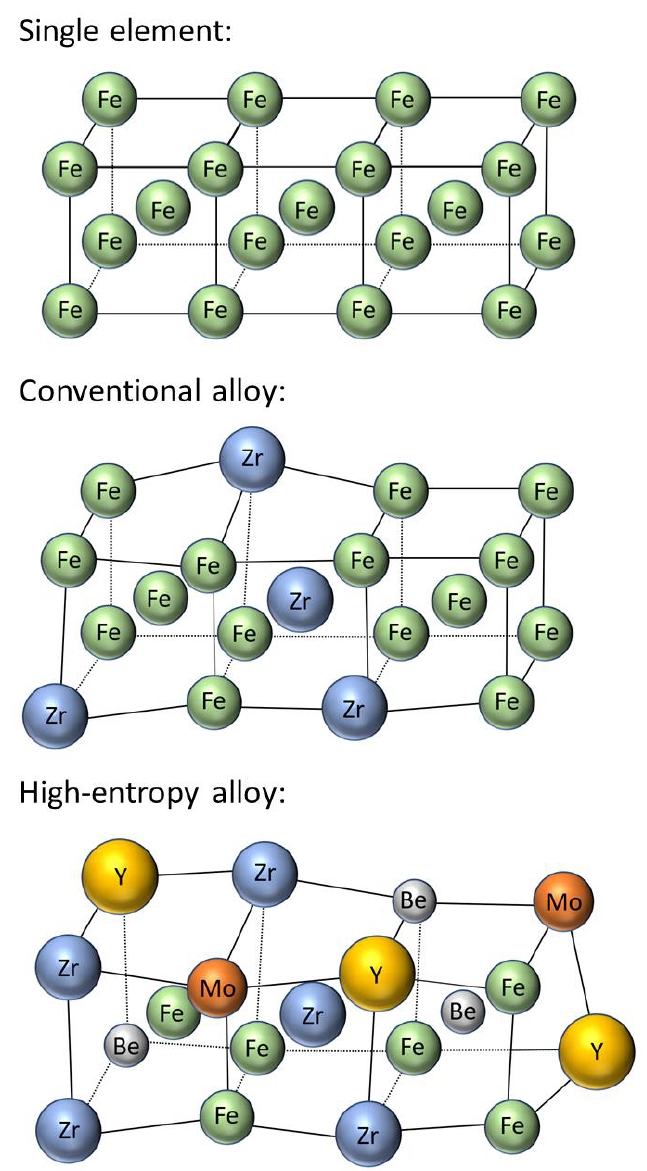
Figure 1. An illustration of the lattice distortion in an element, a conventional alloy, and a high- alloy (adapted from Reference entropy alloy (adapted from Reference [14]).